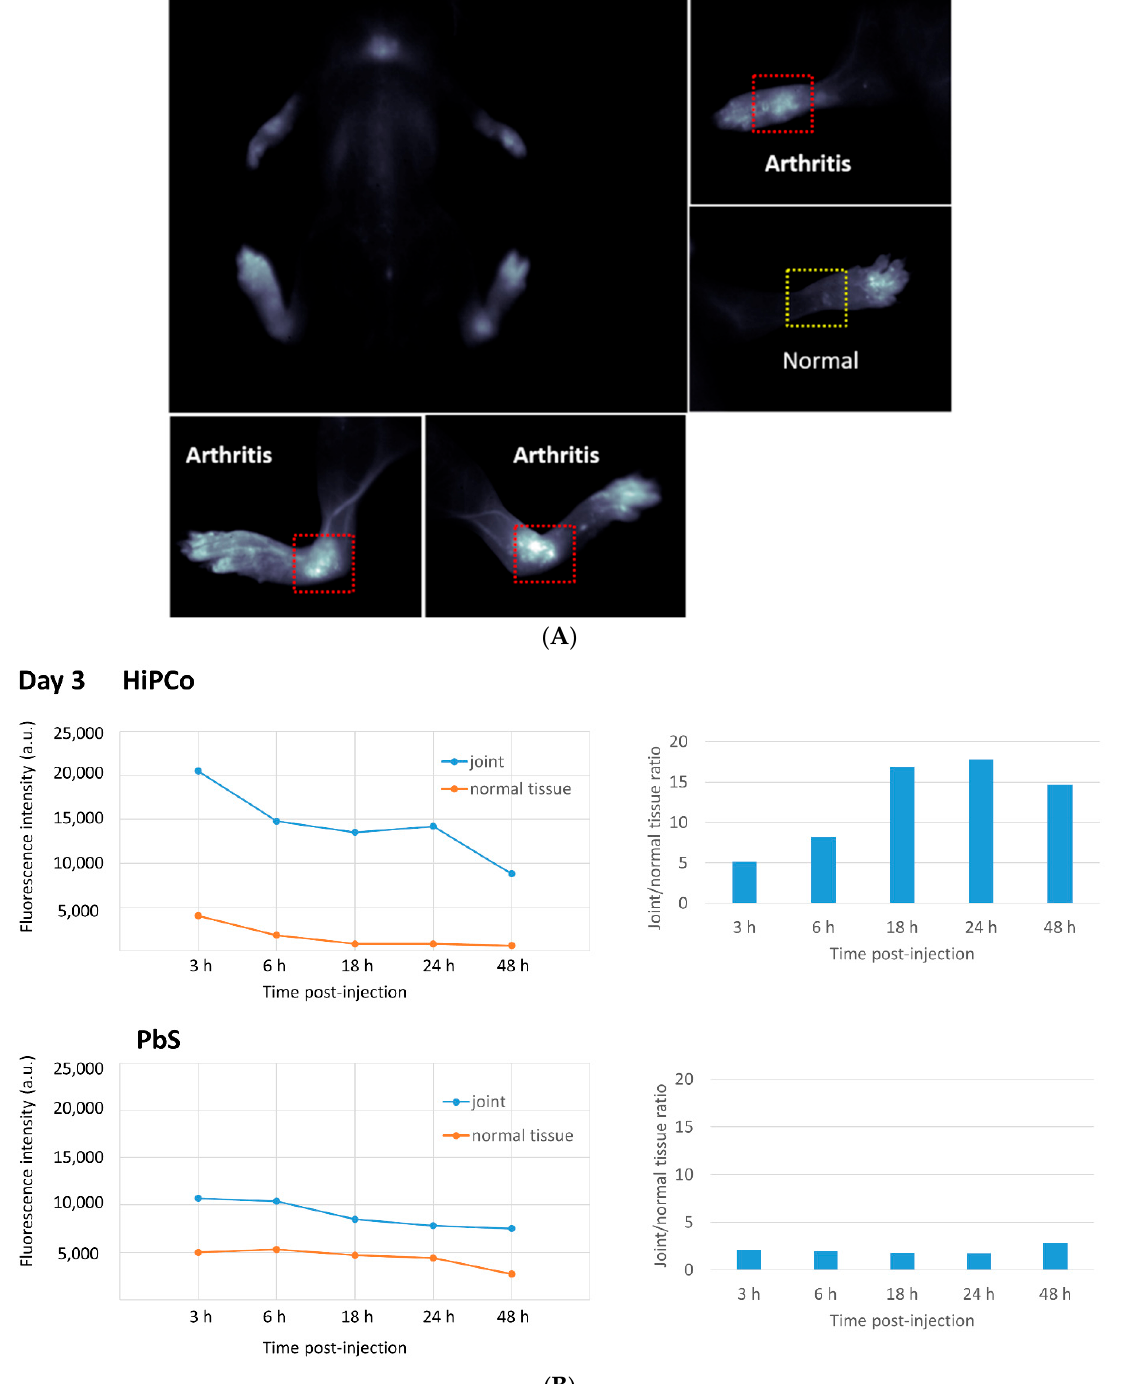
Figure 2. ( A ) Body image of mice 6–9 h after injection. Accumulation of HiPco single-walled carbon nanotubes (SWNTs) Cy5.5 in arthritis joints. ( B ) Relative fluorescence intensity of HiPco and lead sulfide/cadmium sulfide core/shell quantum dots (PbS) in joint and normal tissue ( left ); ratio of fluorescence intensity between joint and normal tissue for HiPco and PbS ( right ).